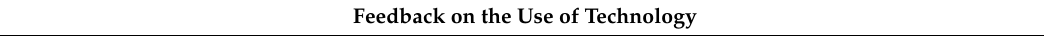
Table 4. Data Supporting “How can technology help?” step of the Pedagogy before Technology model, as per Figure 3.